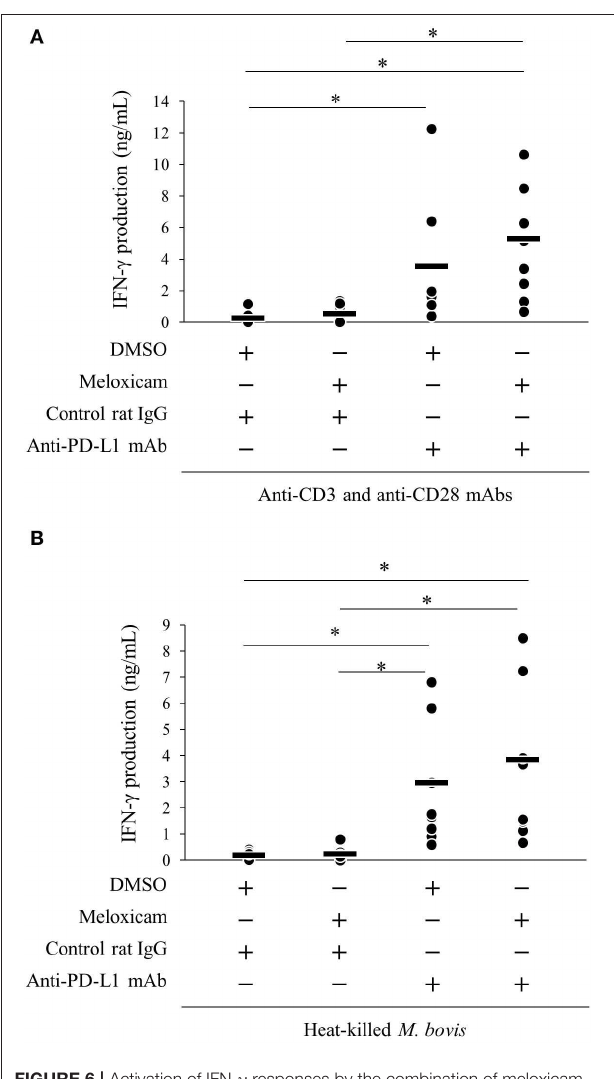
FIGURE 6 | Activation of IFN- γ responses by the combination of meloxicam and anti-PD-L1 Ab. PBMCs from cattle infected with M. bovis ( n = 7) were incubated with meloxicam and anti-PD-L1 mAb in the presence of anti-bovine CD3 and CD28 mAbs (A) or heat-killed M. bovis (B) . IFN- γ production in culture supernatants was determined by ELISA. The bars are the median of the values (A,B) . Statistical significance was determined by the Steel–Dwass test (A,B) . * P <